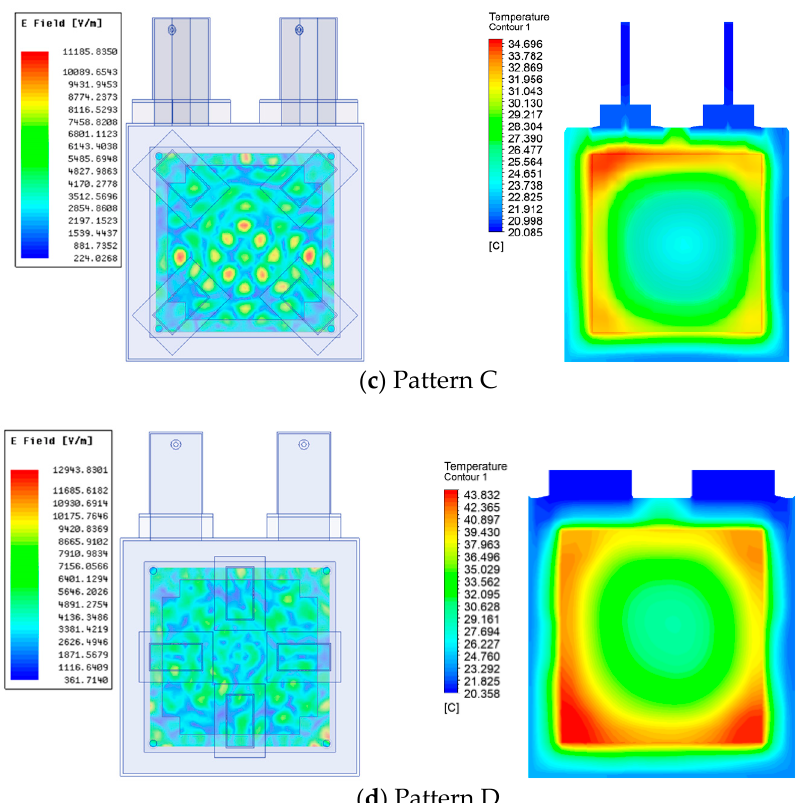
Figure 3. Electric field ( left ) and temperature distribution ( right ) results on the glass surface in accordance with the four waveguide patterns shown in Figure 2.